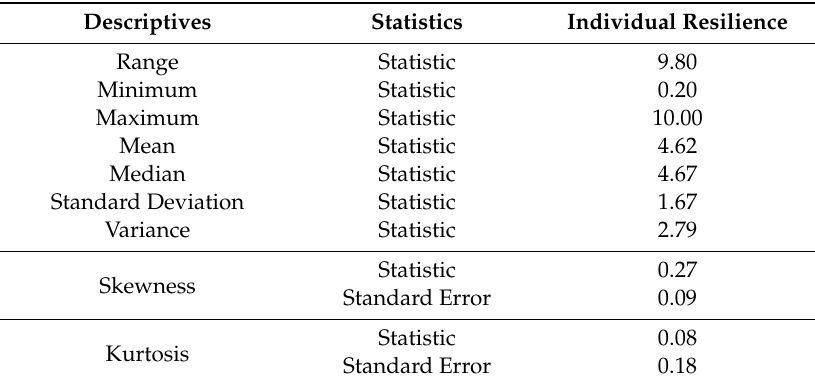
Table 5. Descriptive statistics of individual resilience in Gongming ( n =